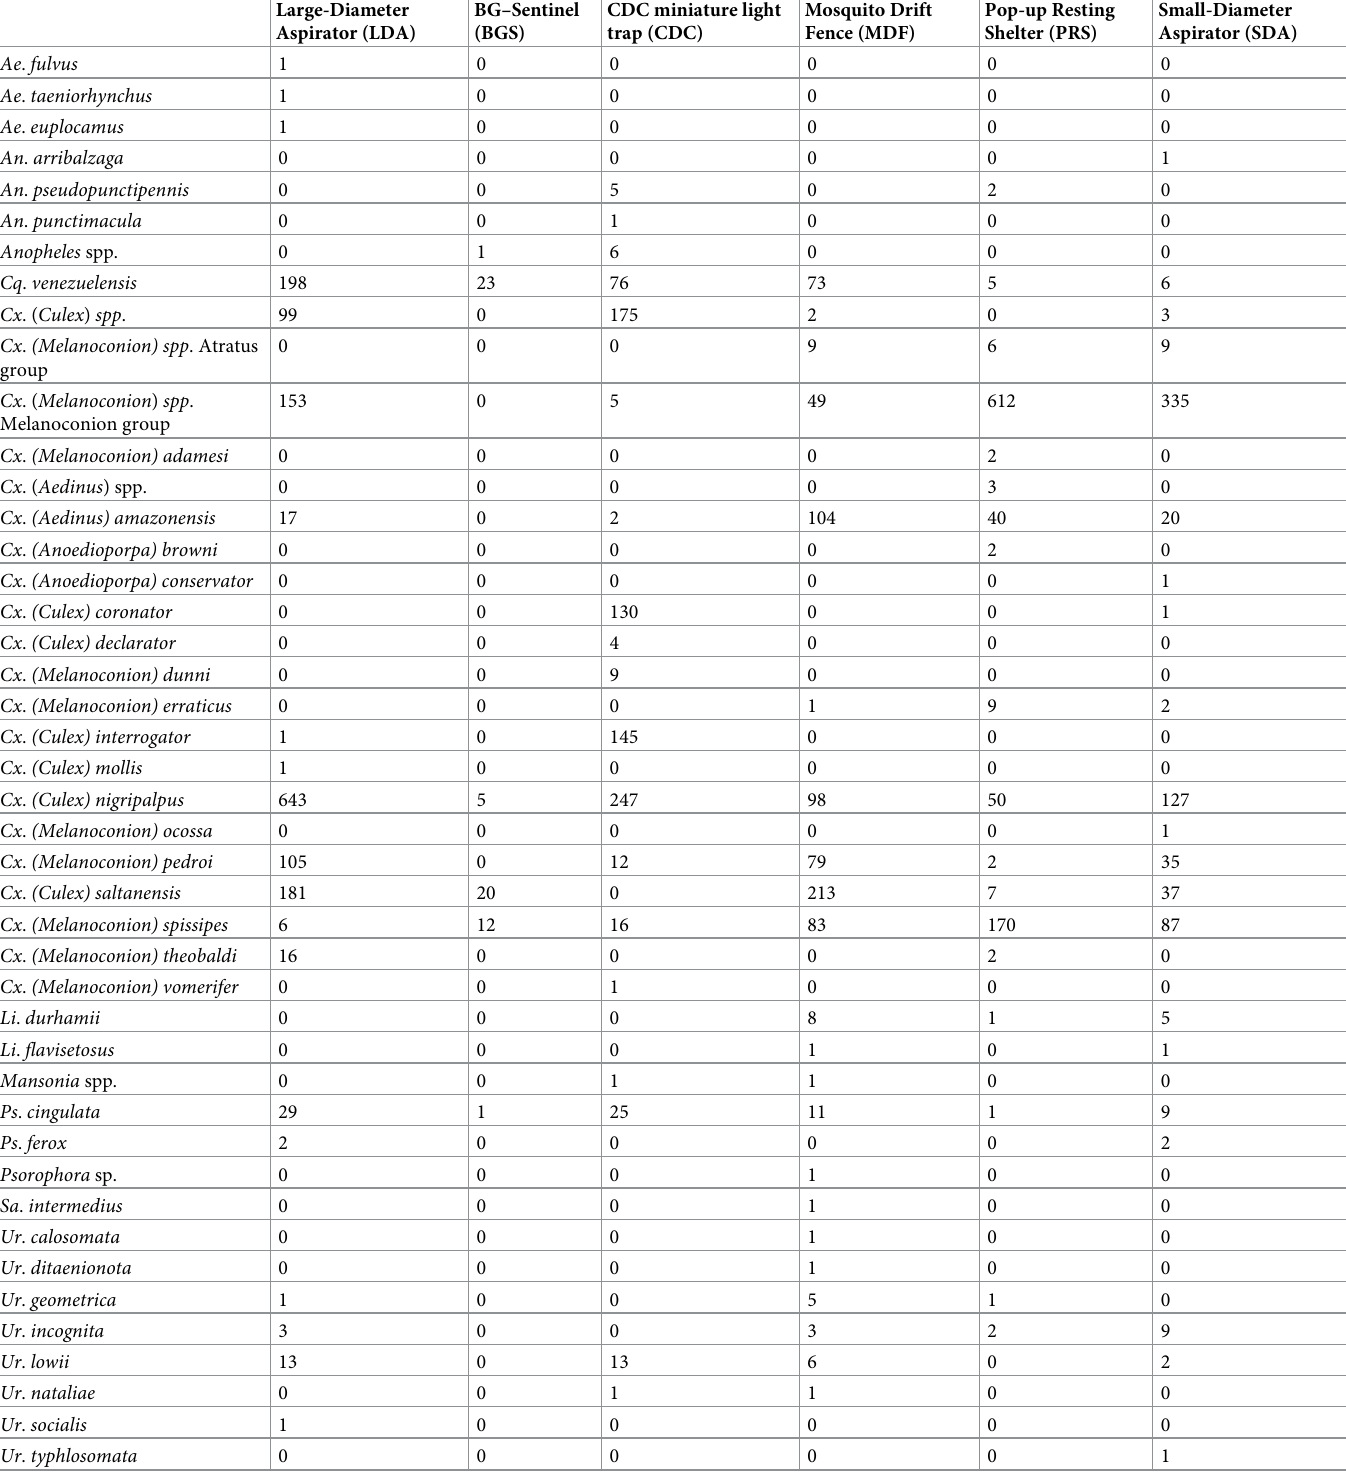
Table 2. Number of each mosquito species captured for the large diameter aspirator (LDA), BG-Sentinel (BGS), CDC miniature light trap (CDC), mosquito drift fence (MDF), pop-up resting shelter (PRS), and the small diameter aspirator (SDA) in Darie´n,